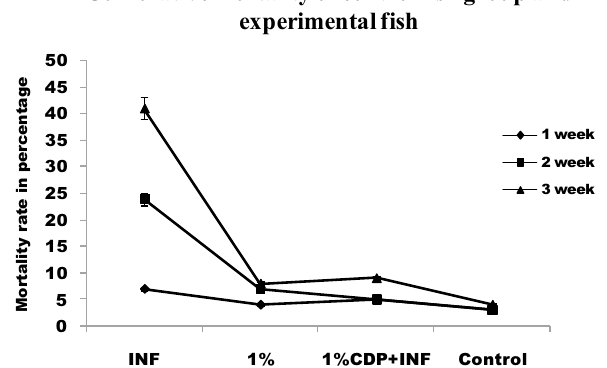
Figure 9. Cumulative mortality of control fish group and experimental fish fed with CDP with basal